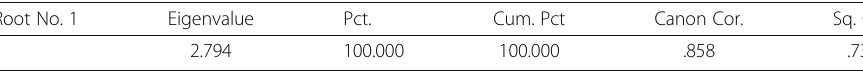
Table 8 Eigenvalues and Canonical Correlations